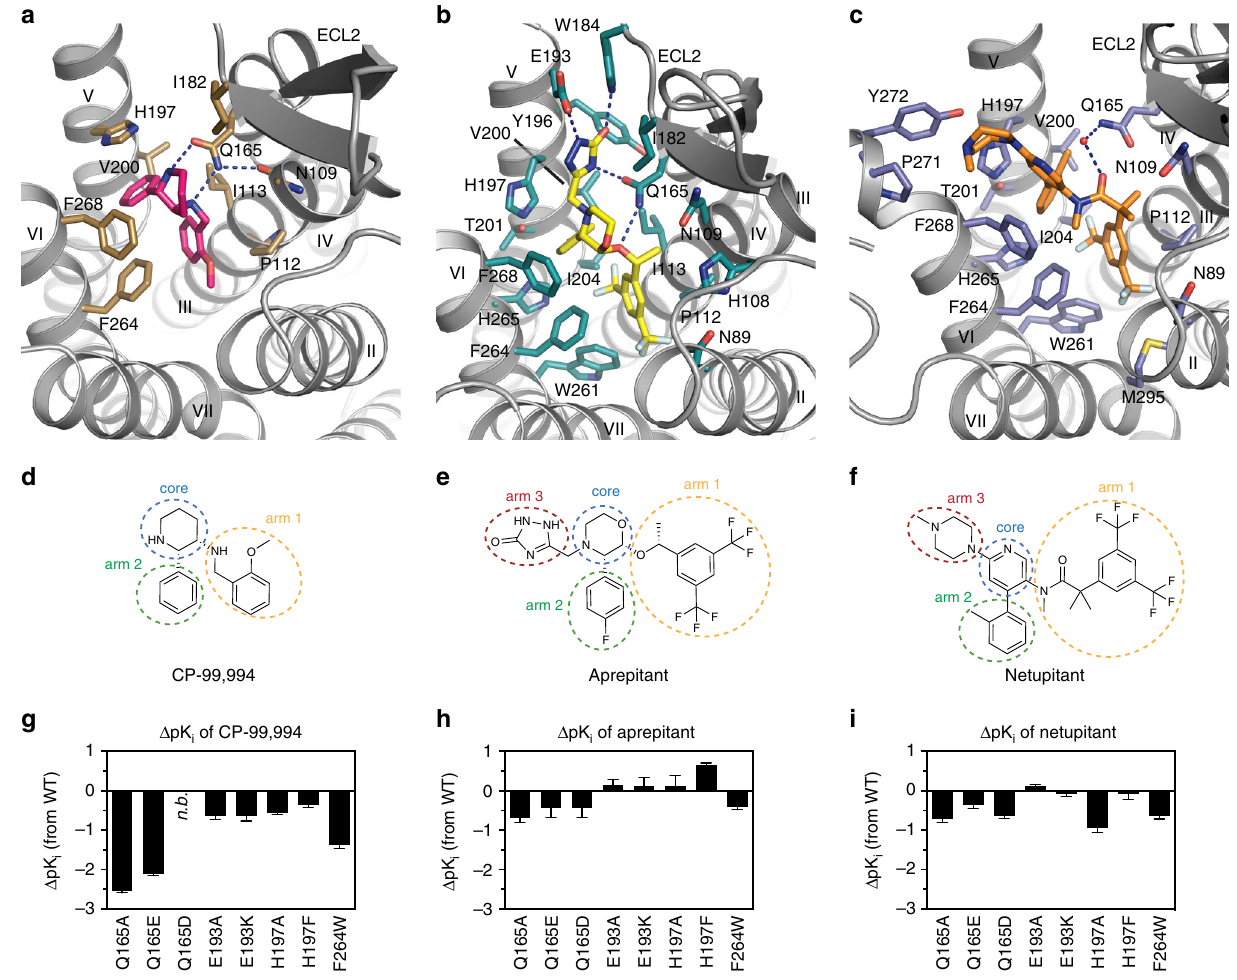
Fig. 2 Drug-binding site of NK 1 R. a – c Detailed interactions of CP-99,994 ( a ), aprepitant ( b ) and netupitant ( c ) with the receptor, viewed from the extracellular side from a position above helix I. The receptor backbone is shown in grey ribbon representation. Ligand and receptor residues within 4 Å of the respective antagonist are shown as sticks and are coloured as in Fig. 1. The ordered water involved in netupitant binding is depicted as a red sphere ( c ). Hydrogen bonds are indicated by dashed blue lines. d – f Chemical structures of CP-99,994 ( d ), aprepitant ( e ) and netupitant ( f ) with structural topology highlighted by coloured, dashed circles (core coloured in blue, arm 1 in yellow, arm 2 in green, arm 3 in red, respectively). g – i Antagonist af fi nity pro fi les of selected mutants in comparison to wild-type NK 1 R. pK i values for each antagonist were derived from competition ligand-binding experiments (Supplementary Table 1). Bars represent differences in calculated af fi nity (pK i ) values for each mutant relative to the wild-type receptor for CP-99,994 ( g ), aprepitant ( h ), and netupitant ( i ). Data are shown as mean values ± s.e.m. from three to fi ve independent experiments performed in duplicates. n.b.